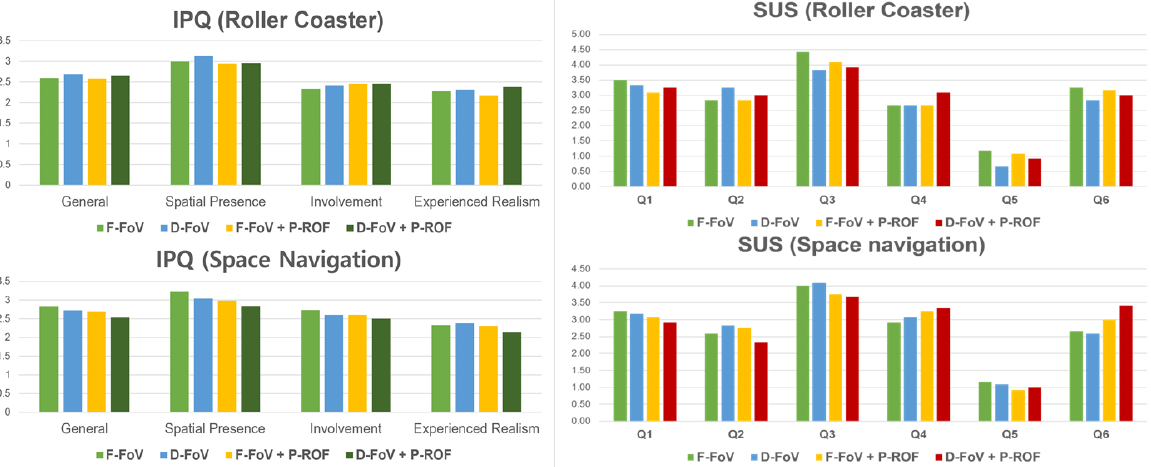
Figure 7. Effects on VR user experience (presence/immersion) using the IPQ and SUS questionnaires: roller coaster ( top ) and space navigation ( bottom